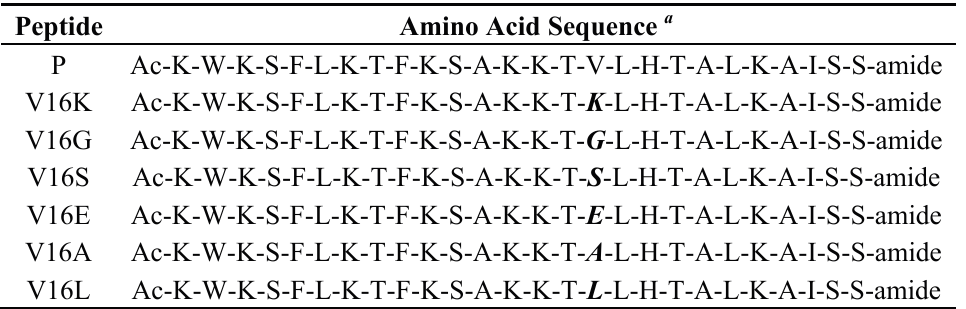
Table 1. Sequence of peptides used in this